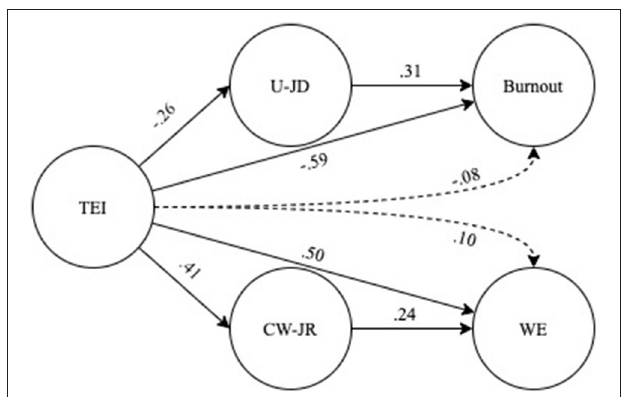
FIGURE 2 | Summary of the results of structural equation model. TEI, trait emotional intelligence; U-JD, end-user job demands; DUC, dealing with users’ complaints; CW-JR, coworkers related job resources; WE, work engagement. Continuous lines = direct relationship; discontinuous lines = indirect relationship. All direct and indirect paths coefficients were statistically significant at p <